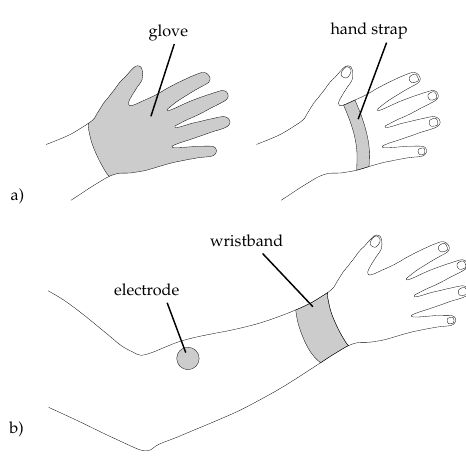
Figure A1. Types of wearables for the human hand or lower arm in dorsal view. Mechanical support structures shown in grey. ( a ) Wearables for the hand. Left: gloves. Right: hand straps. ( b ) Wearables for the lower arm using wrist straps or additional elements, such as electrodes for electromyography.